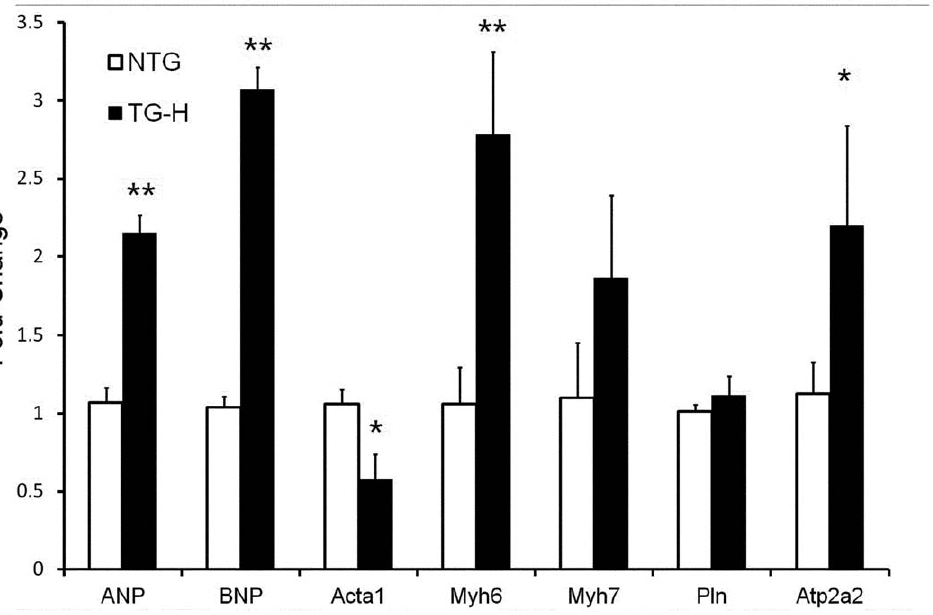
Figure 4. Assessment of hypertrophy marker genes. The mRNA levels were measured in left ventricle by RT-PCR analysis (N=4 hearts in each group). Gapdh was used for internal control. **: P , 0.01, *: P , 0.05 vs nontransgenic